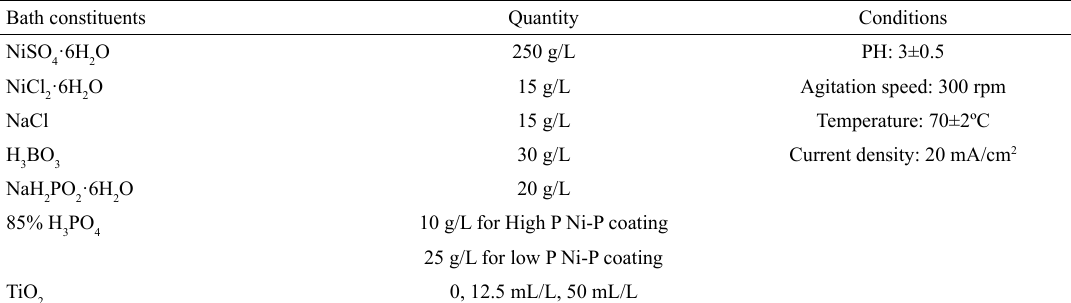
Table 1. Bath composition and electroplating parameters for basic Ni-P coating. Bath constituents